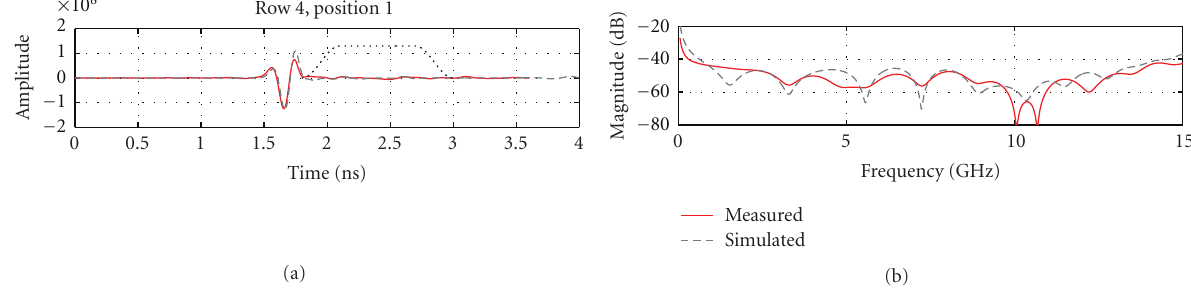
Figure 14: (a) Calibrated reflection from the breast model recorded at the same position as in Figure 13 but without any inclusion present. Dotted line shows the extent of the Tukey window that is used to isolate the later-time response. (b) The frequency response of the later-time component of the